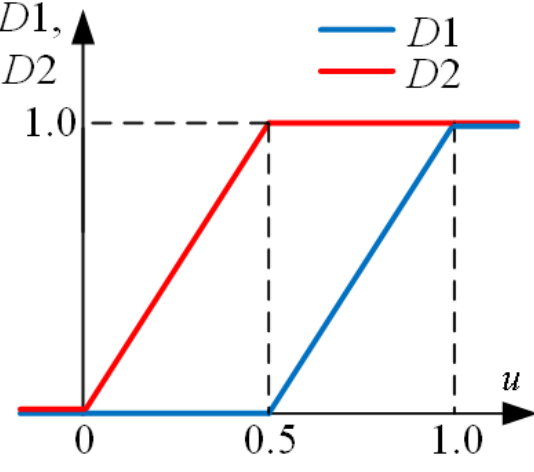
Figure 9. Control characteristic of the solar panel